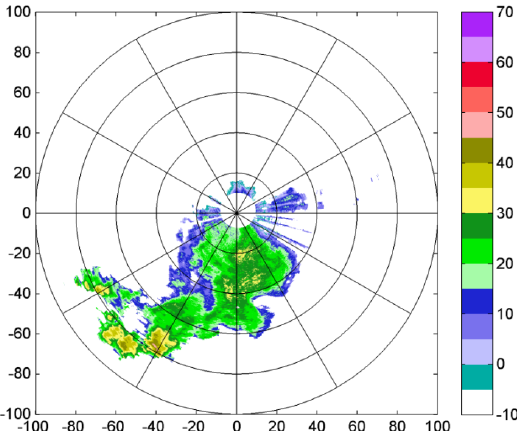
Figure 13. Original reflectivity at X-band for the stratiform cloud with embedded convection on 26 June 2015.